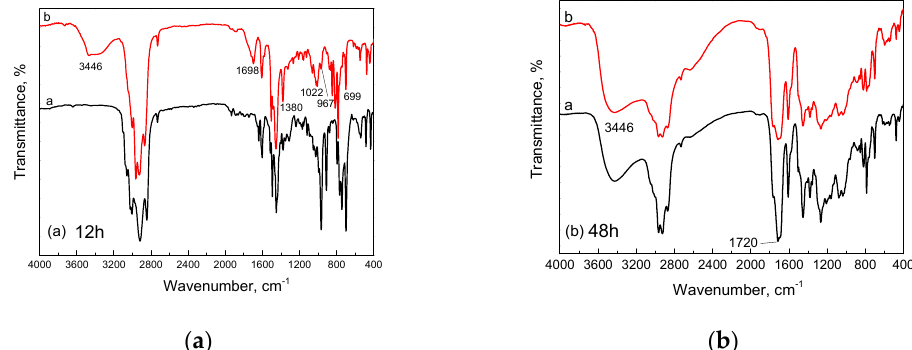
Figure 6. Effect of oxygen concentration on the molecular structure of the SBS in ( a ) short-term or ( b ) long-term aging (Oxygen flowrate: ( a ) 0.25 L/min; ( b ) 1 L/min; aging temperature: 150 °C).